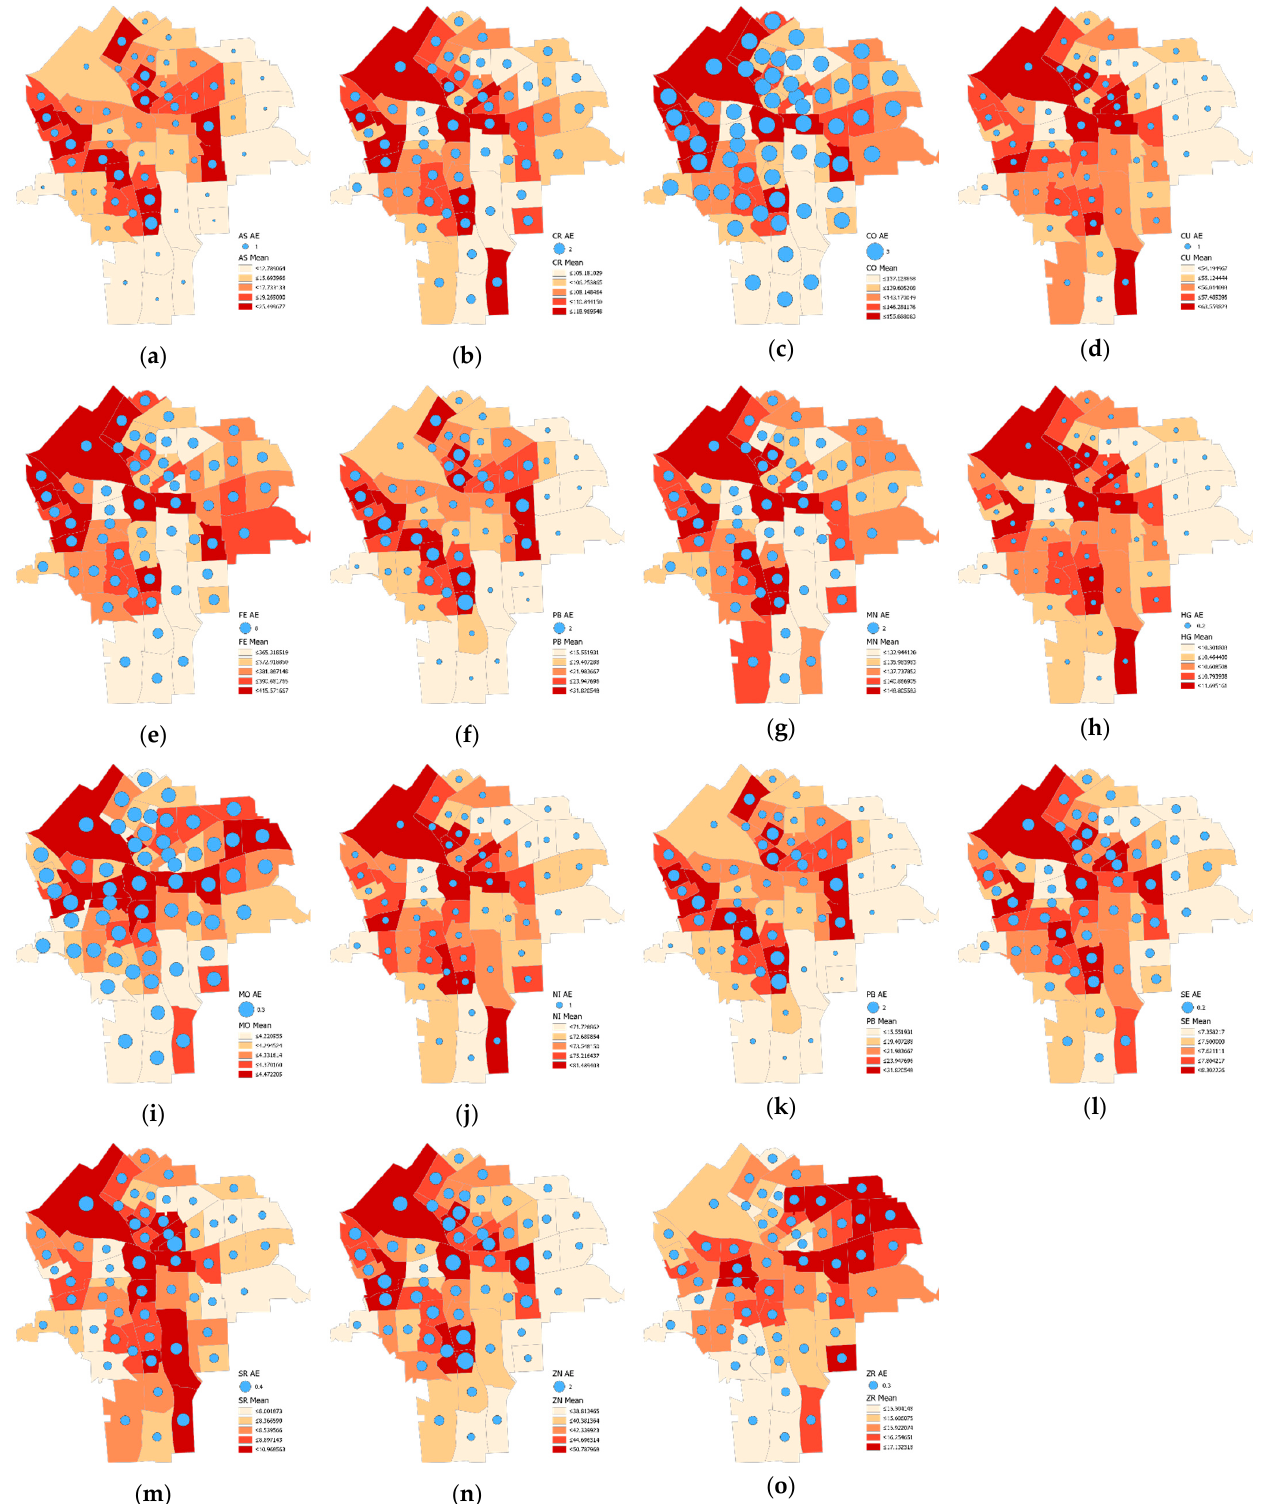
Figure 6. Choropleth maps with superimposed theoretical analytical measurement error magnitude proportional circles portraying each of the 15 trace metals (census tract resolution): ( a ) As, ( b ) Cr, ( c ) Co, ( d ) Cu, ( e ) Fe, ( f ) Pb, ( g ) Mn, ( h ) Hg,